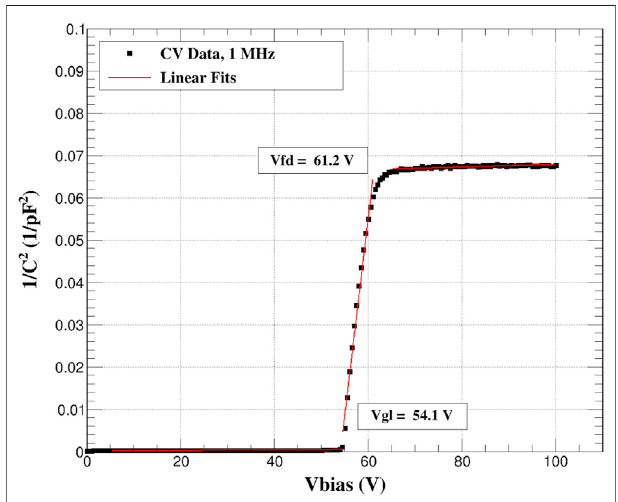
Frontiers in Physics |